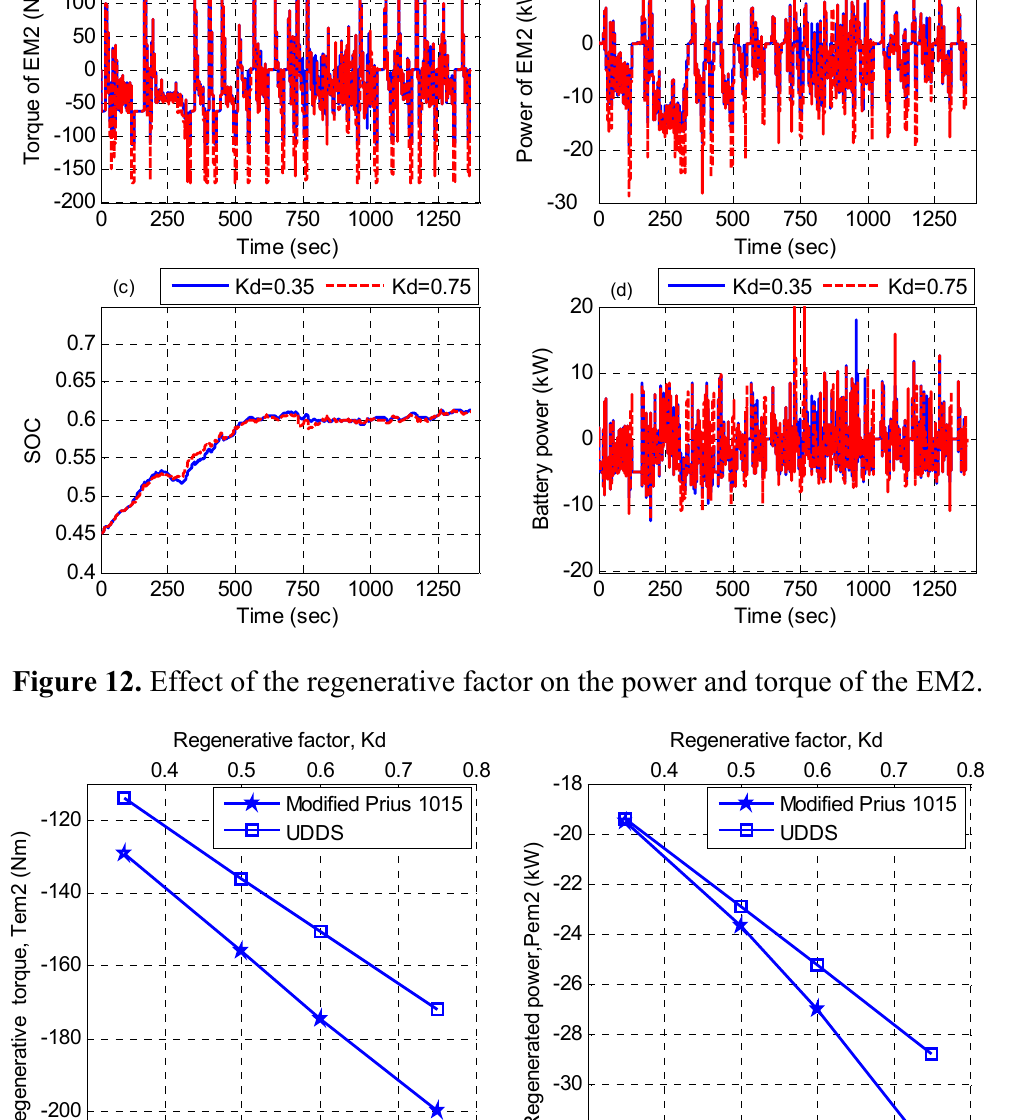
(cid:3404) 35 % and (cid:1837) (cid:3404) 75 % with the (cid:3031) (cid:3031)